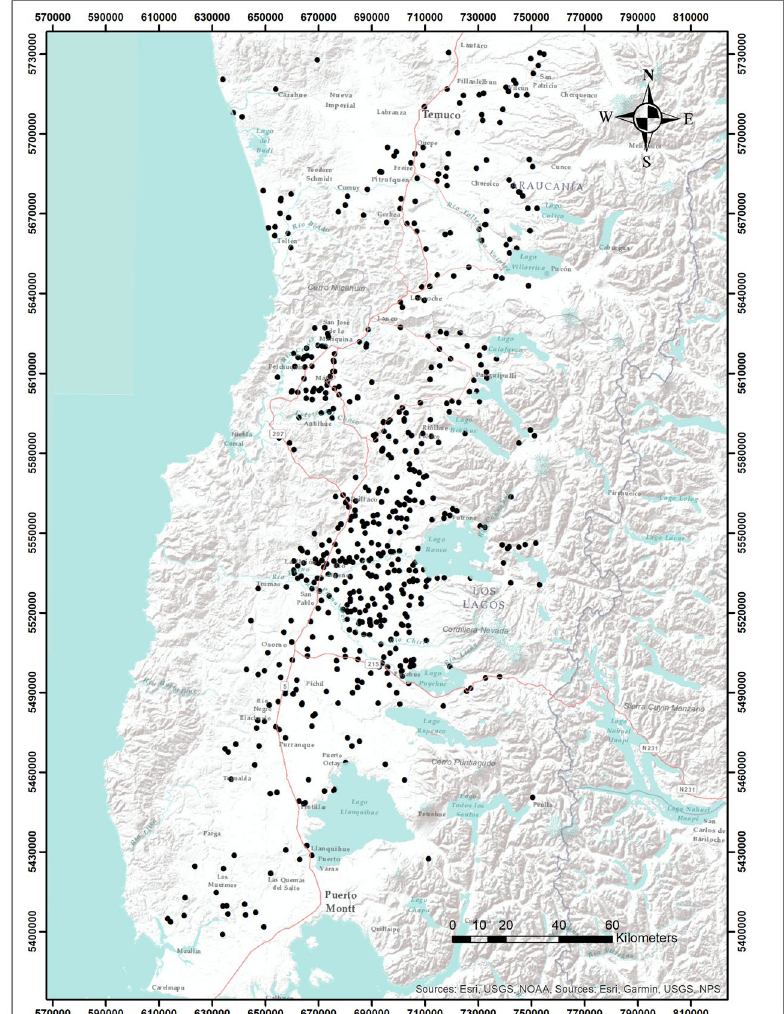
Fig. 2 Farm locations accord- ing to SAG database